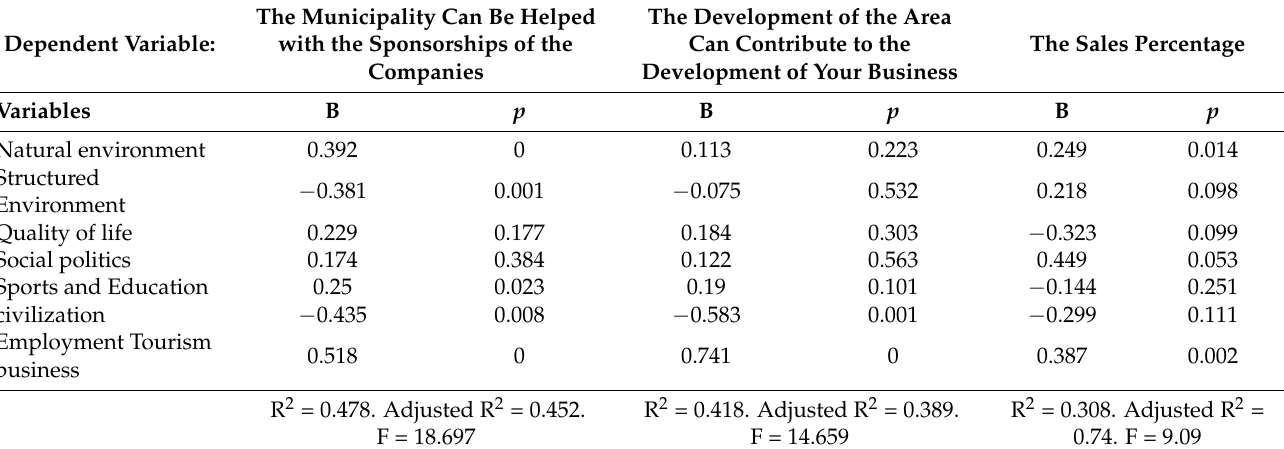
Table 3. Multiple Linear Regression Analysis